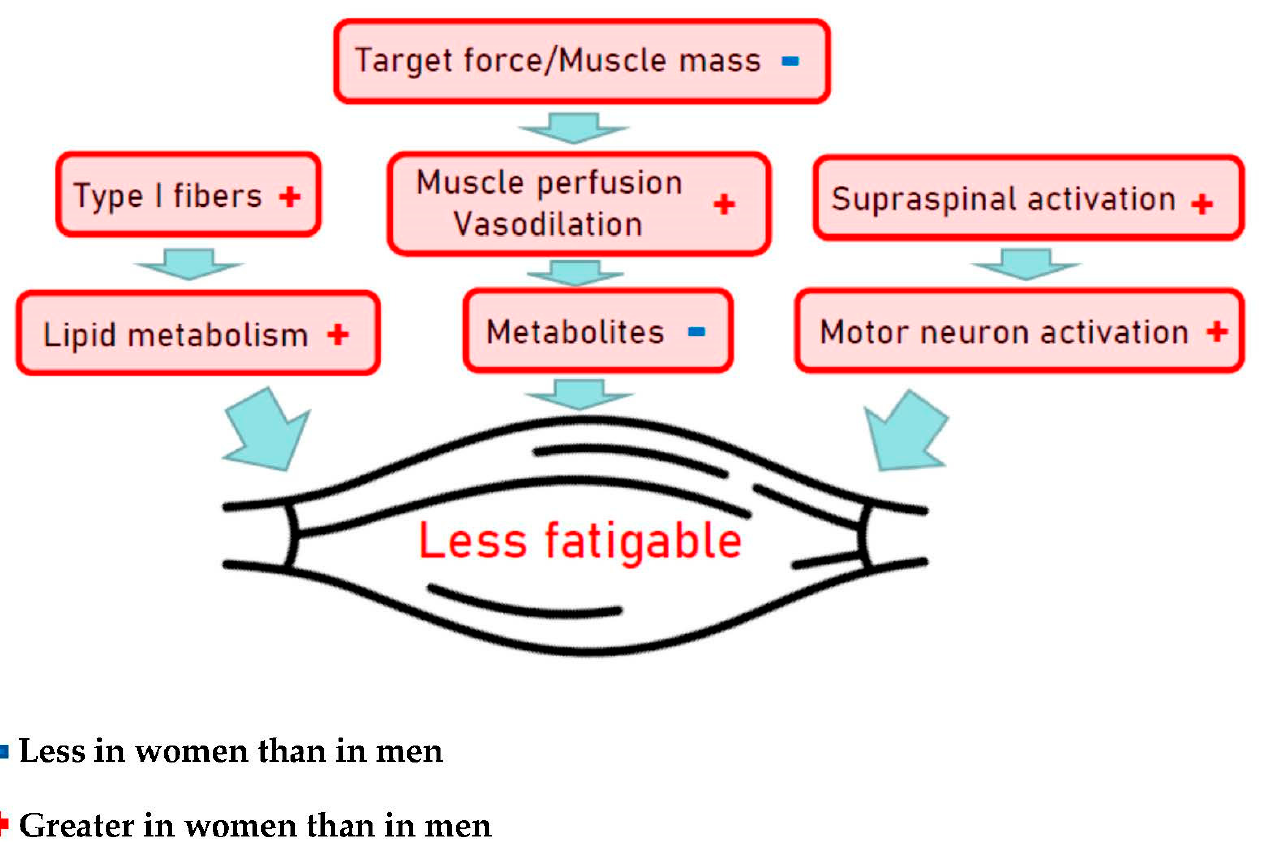
Figure 4. Mechanisms potentially contributing to the less fatigability of skeletal muscles in females. Modified according to Hunter [158].